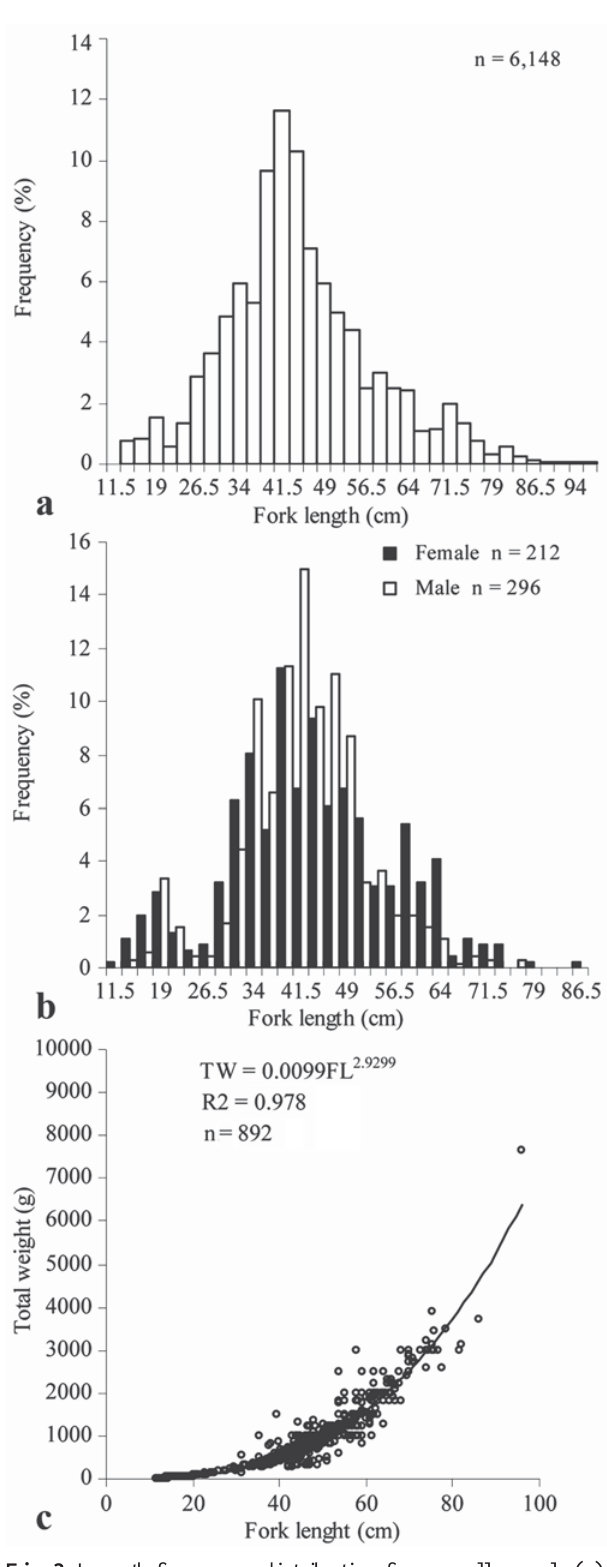
Fig. 3. Length frequency distribution for overall sample (a); Frequency distribution of male and female lengths (b); Relationship between FL and TW (combined sexes) showing adjusted potential model (c) of Spanish mackerel off northeastern Brazil.